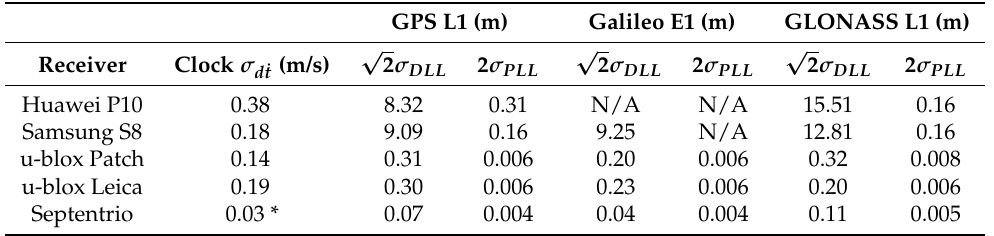
Table 1. Table for the measured error model parameters in open sky conditions, from Equations (6), (17), and (21). Parameters are for the models in Equations (7), (18), and (23). See Figure 1 about the test setup. (*) See the text for details. GPS L1 (m) Galileo E1